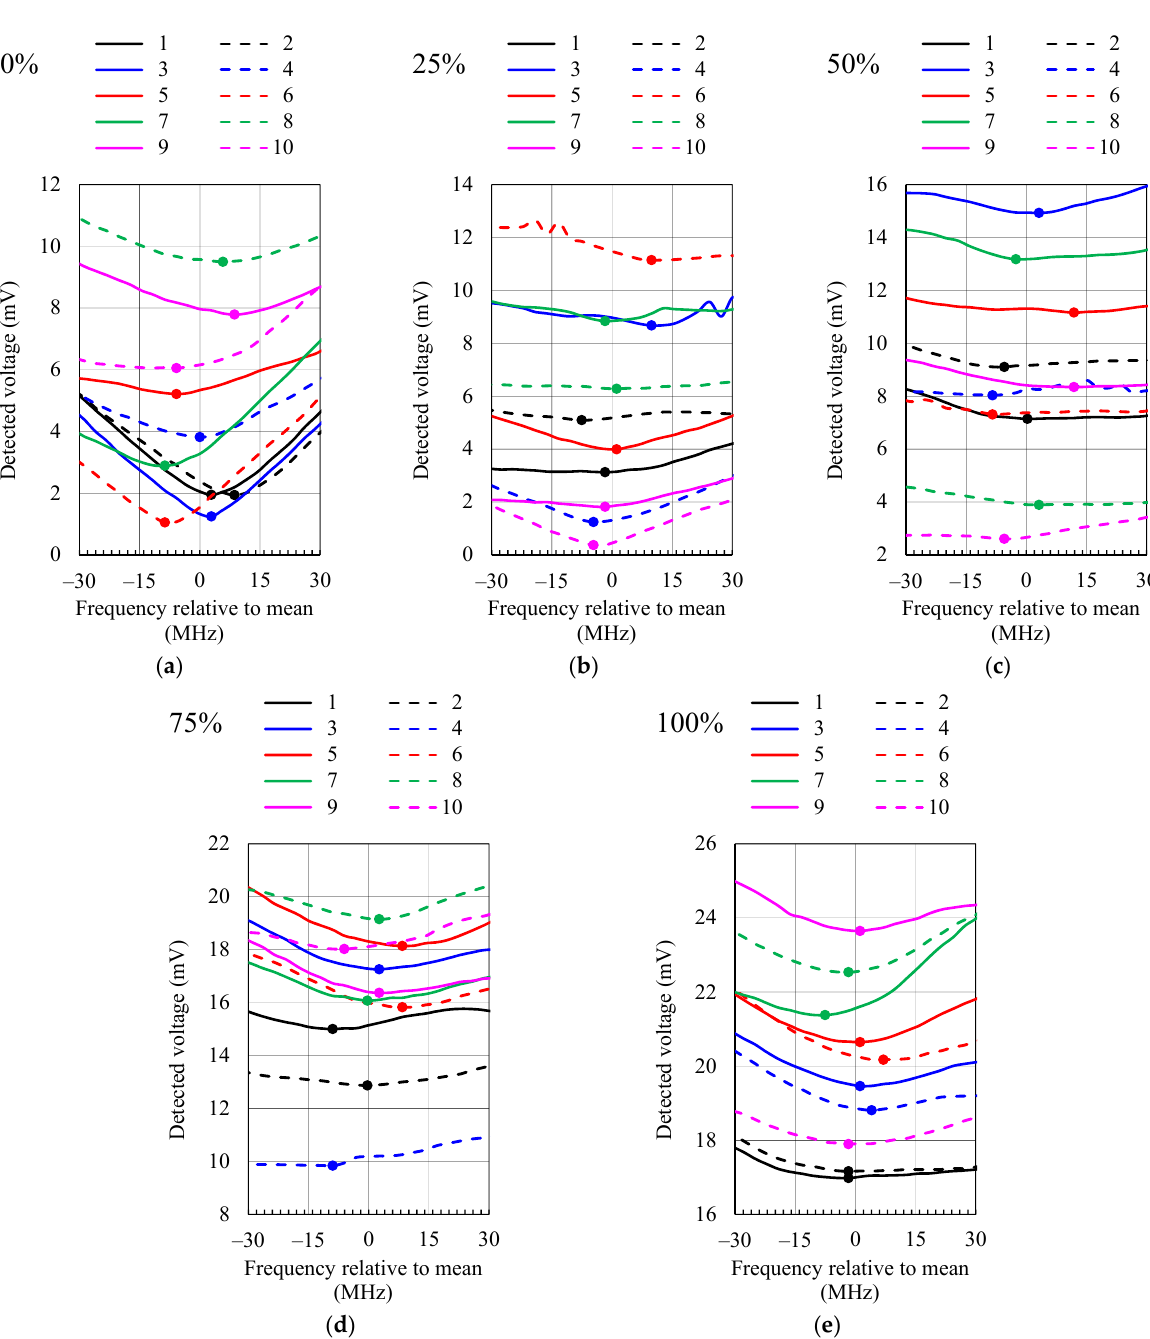
Figure 21. Measured detected voltage around the minima for ten measurement series and for moisture content: ( a ) 0%, ( b ) 25%, ( c ) 50%, ( d ) 75%, and ( e ) 100%. The series for increasing moisture content are marked with odd numbers and plotted with solid lines, while the series for decreasing moisture content are marked with even numbers and plotted with dashed lines. The marker shows the minimum detected voltage.